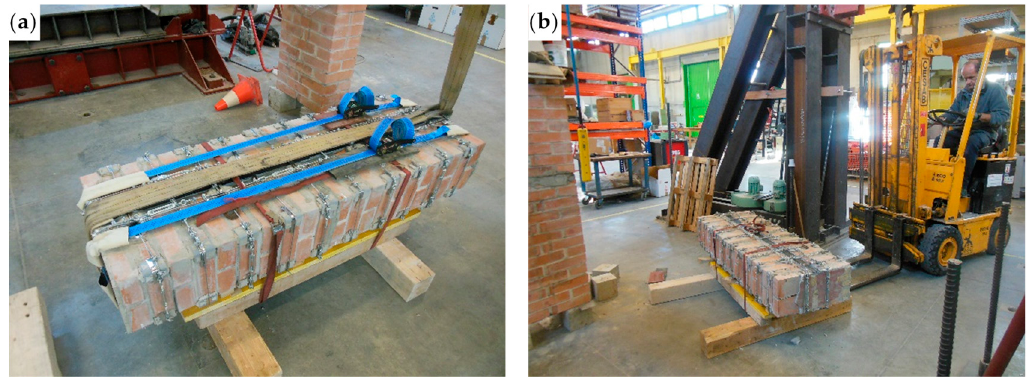
Figure 45. Handling of Specimen W5: ( a ) overturning of the specimen on the wooden beams, with the wooden “stretcher” placed below and ( b ) positioning the forklift forks to lift the specimen.